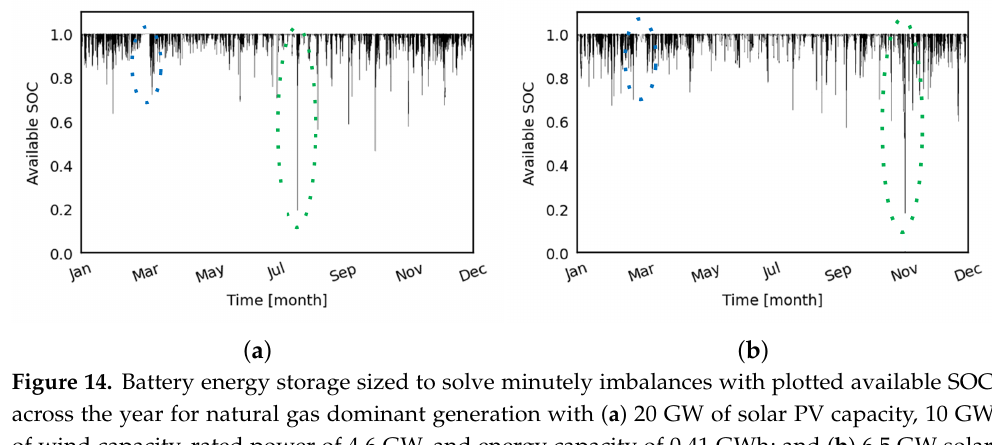
Figure 14. Battery energy storage sized to solve minutely imbalances with plotted available SOC across the year for natural gas dominant generation with ( a ) 20 GW of solar PV capacity, 10 GW of wind capacity, rated power of 4.6 GW, and energy capacity of 0.41 GWh; and ( b ) 6.5 GW solar, 3.25 GW wind, 2.5 GW power, and 0.112 GWh energy capacity. Dominant renewable generation significantly shifts the expected maximum peaking power to meet quick drops in VRE output and BESS energy capacity is non-linearly related to renewable capacity.